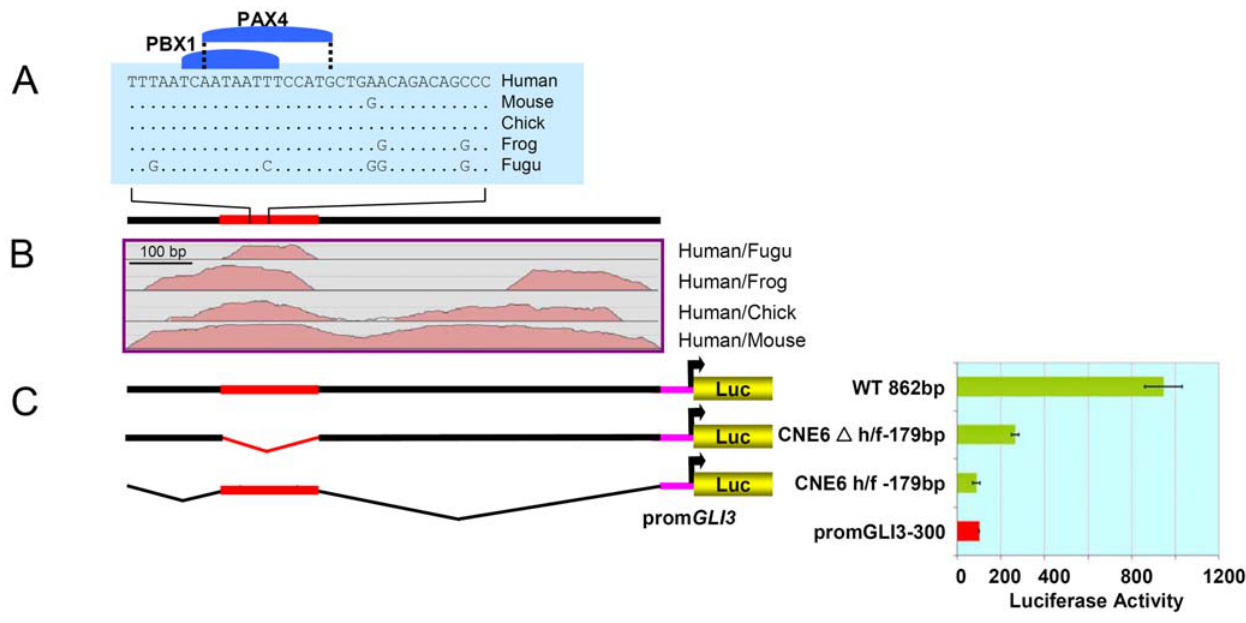
Figure 7. CNE6 Sequences Flanking Human/Fish conserved Track Show Residual Enhancer Activity. (A) BLASTZ alignment of the highest conserved 35 bp along with two predicted conserved TFBSs from the human/ Fugu conserved block within CNE6. (B) CNE6 alignment plot of human, mouse, chick, frog and Fugu sequences using human sequence as the base line. (C) Architecture of wild type and deletion constructs; the red bar depicts the highly conserved human/fish segment. Luciferase activity obtained in H661 cells after transient transfection of reporter constructs is shown in the diagram at the right side. Reporter gene expression is driven by CNE5 fragments upstream of the human GLI3 minimal promoter. The red bar depicts luciferase expression (100%) in H661 cells driven alone by the control GLI3 minimal promoter (Prom GLI3 -300), whilst the green bars represent the activity recorded for the vectors containing experimental reporter constructs, i.e. wild type CNE6 (wt 862bp), CNE6 with deleted human/ Fugu conserved block ( CNE6 D h/f-179bp ), and the 72% human/fish conserved fragment ( CNE6h/f-179bp ). CNE6 D h/f-179bp can still enhance reporter gene transcription more than two-fold. The isolated 179 bp fragment cannot activate expression.